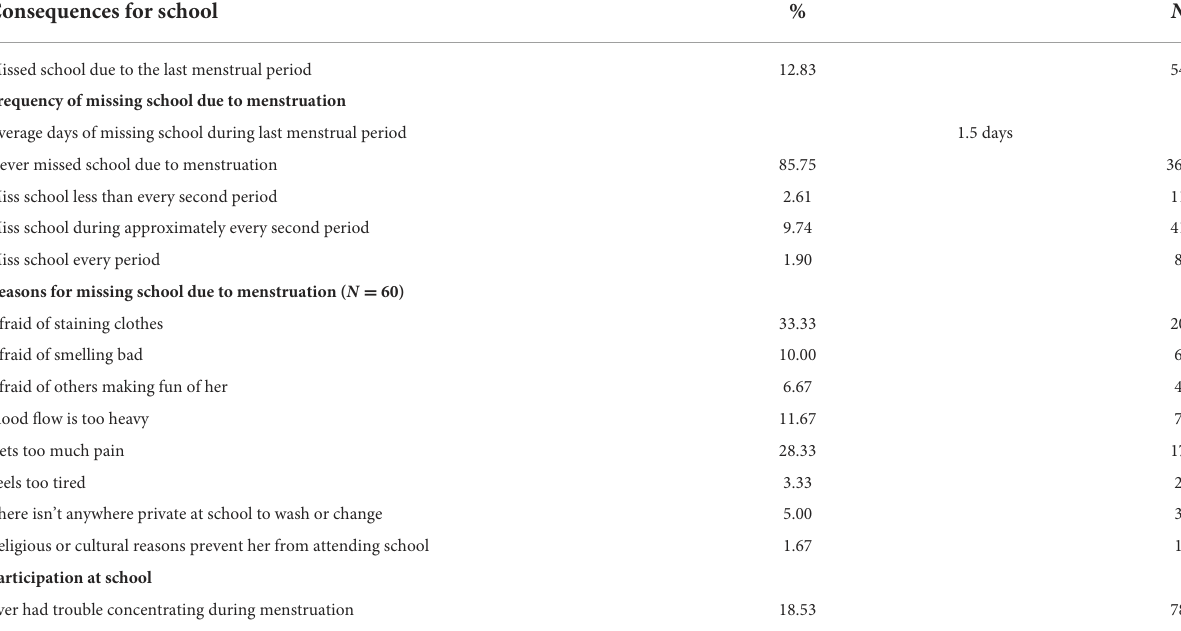
TABLE 1 Proportion of post-menarche girls reporting school difficulties due to menstruation ( n = 421). Consequences for school